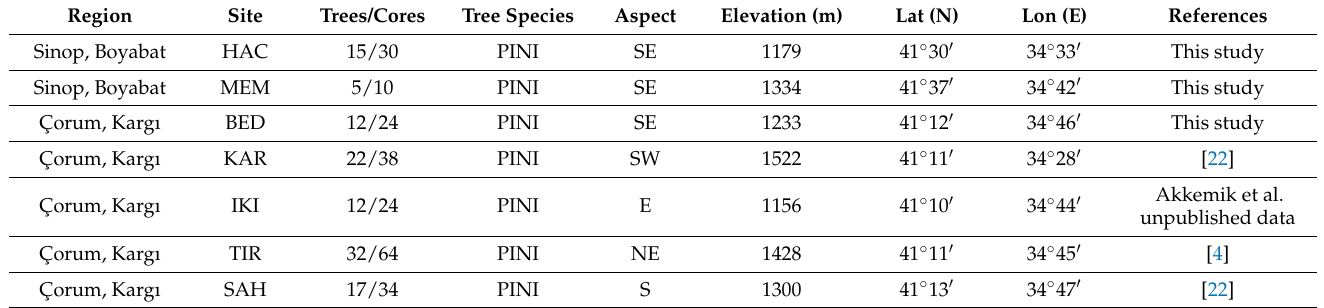
Table 1. The site characteristics and the details of the tree-ring chronology data used in the